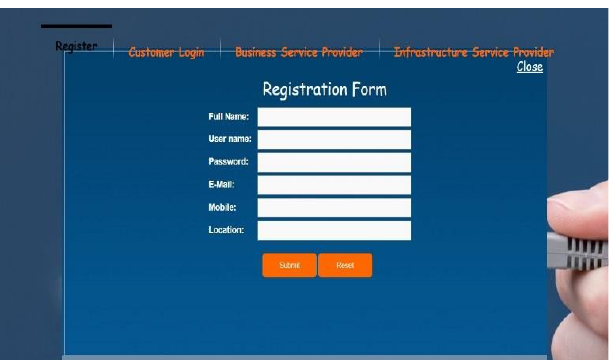
Figure 4. Customer Registration Page